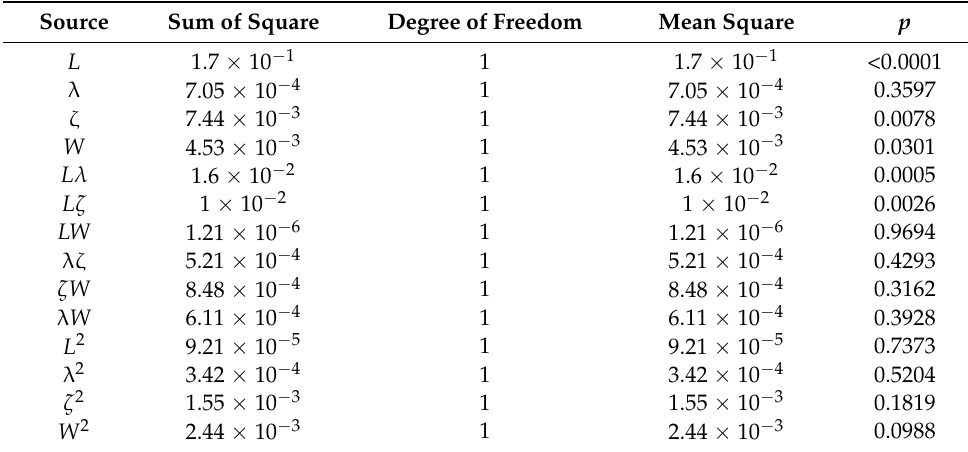
Table 5. Preliminary significance analysis results of model Φ F .